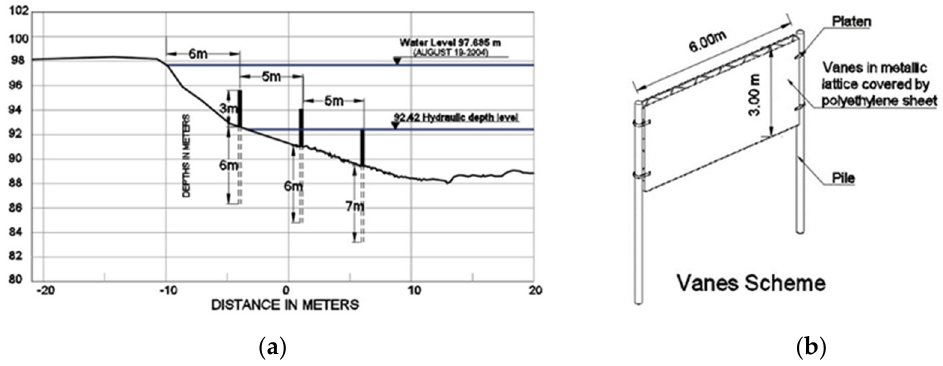
Figure 7. Sinú River, Trementino: ( a ) installation scheme; ( b ) characteristics of the panels (Hidroconsulta, 2004 [9]).